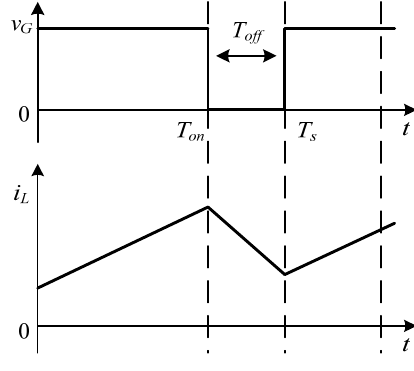
Figure 7. Continuous current